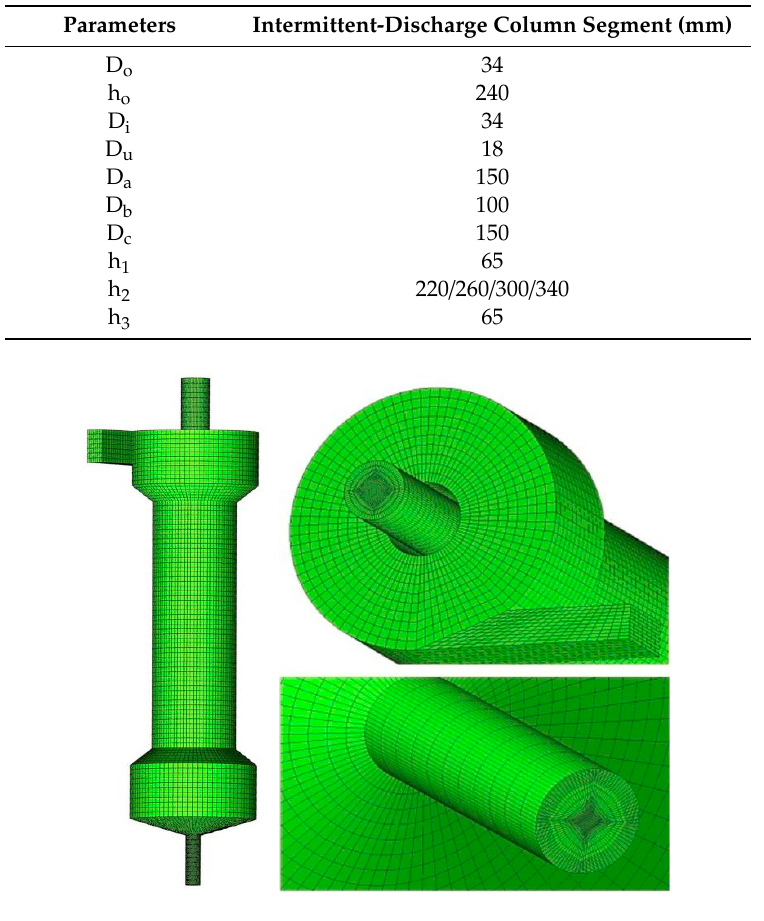
Table 3. Particle size